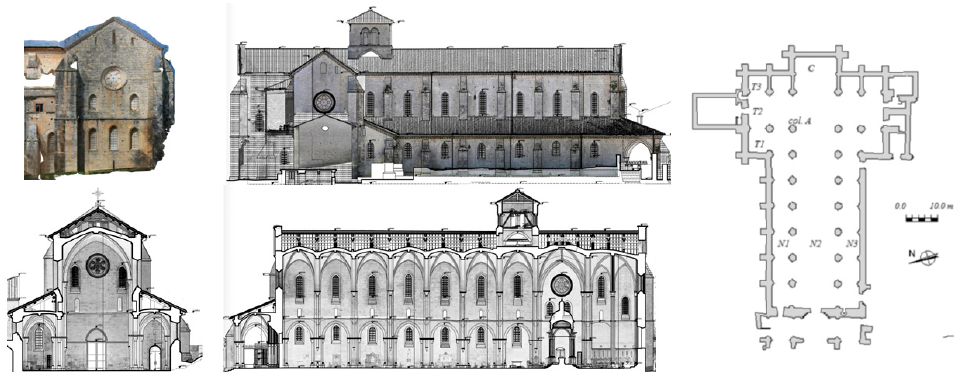
Figure 2. Views of the